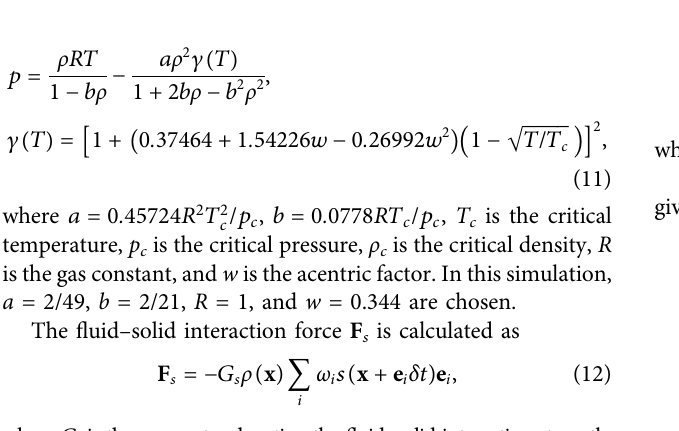
FIGURE 2 | Schematicdiagramofheavingmotionandforceanalysis. (A) Varianceofheavingdisplacement h andratio( a h + g )/g. (B) Forceanalysisinoneheavingperiod.